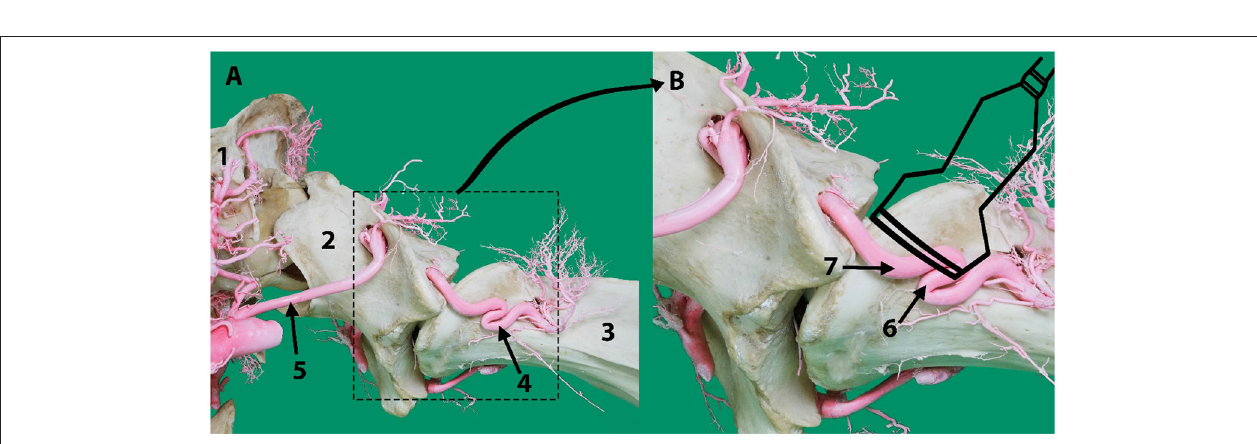
FIGURE 1 | Transcranial Color Doppler flow images at the atlanto-occipital window where (A) transverse plane and (B) sagittal plane. Here the basilar artery is blue (arrowed) and the two red spots are the double root of the caudal cerebellar artery; (C) transverse plane at the level between the first and the second cervical vertebrae. Here blue (arrowed) is the vertebral artery with blood flow toward the brain. The red highlighted area of the vertebral artery indicates the blood flow toward the transducer due to the curved route of the vertebral artery in this area. Red indicated blood flow toward the transducer and blue is away from the transducer.